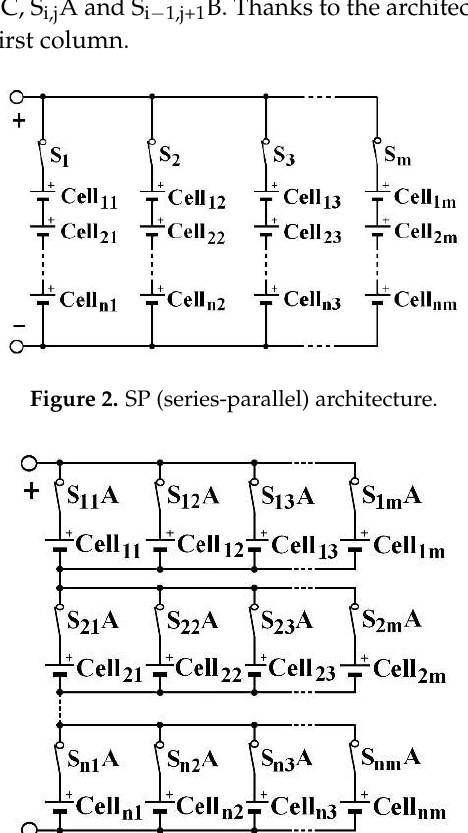
Figure 3. PS (parallel-series) architecture.